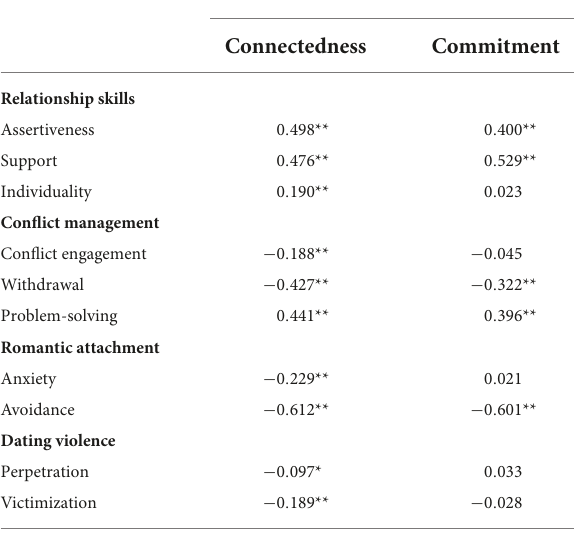
TABLE 4 Convergent and divergent validity of the Relationship Quality Inventory for Adolescents (RQI-A) ( n =